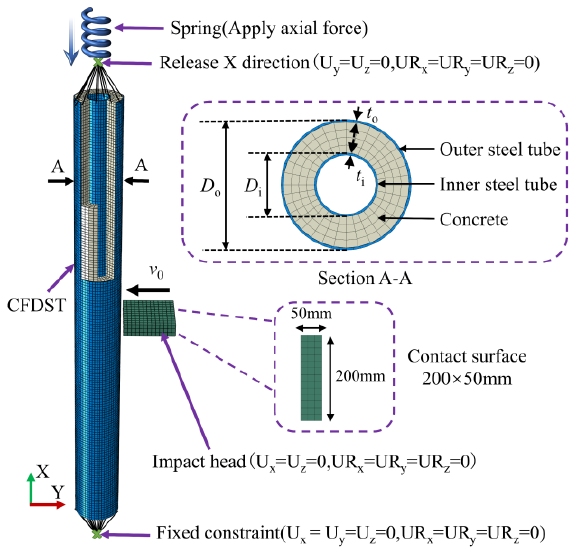
Figure 2. Numerical model of CFDST column.